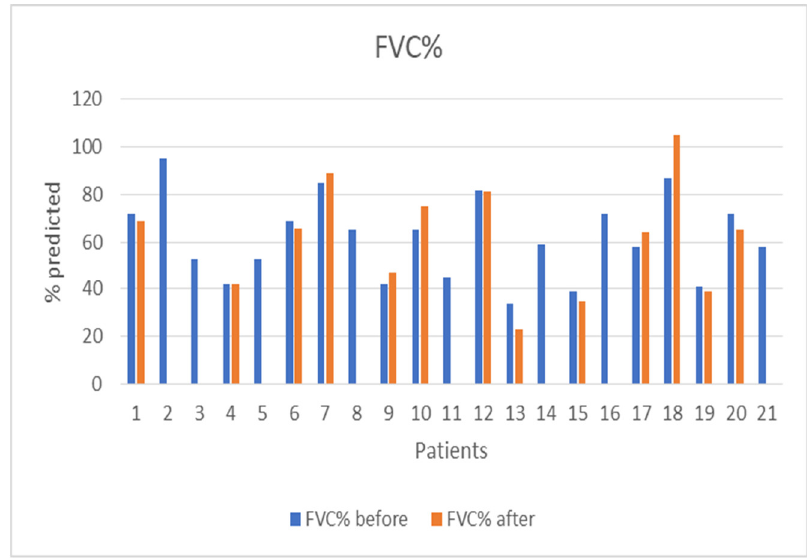
Figure 3. Patients’ FVC (% pred) before and after nintedanib treatment.